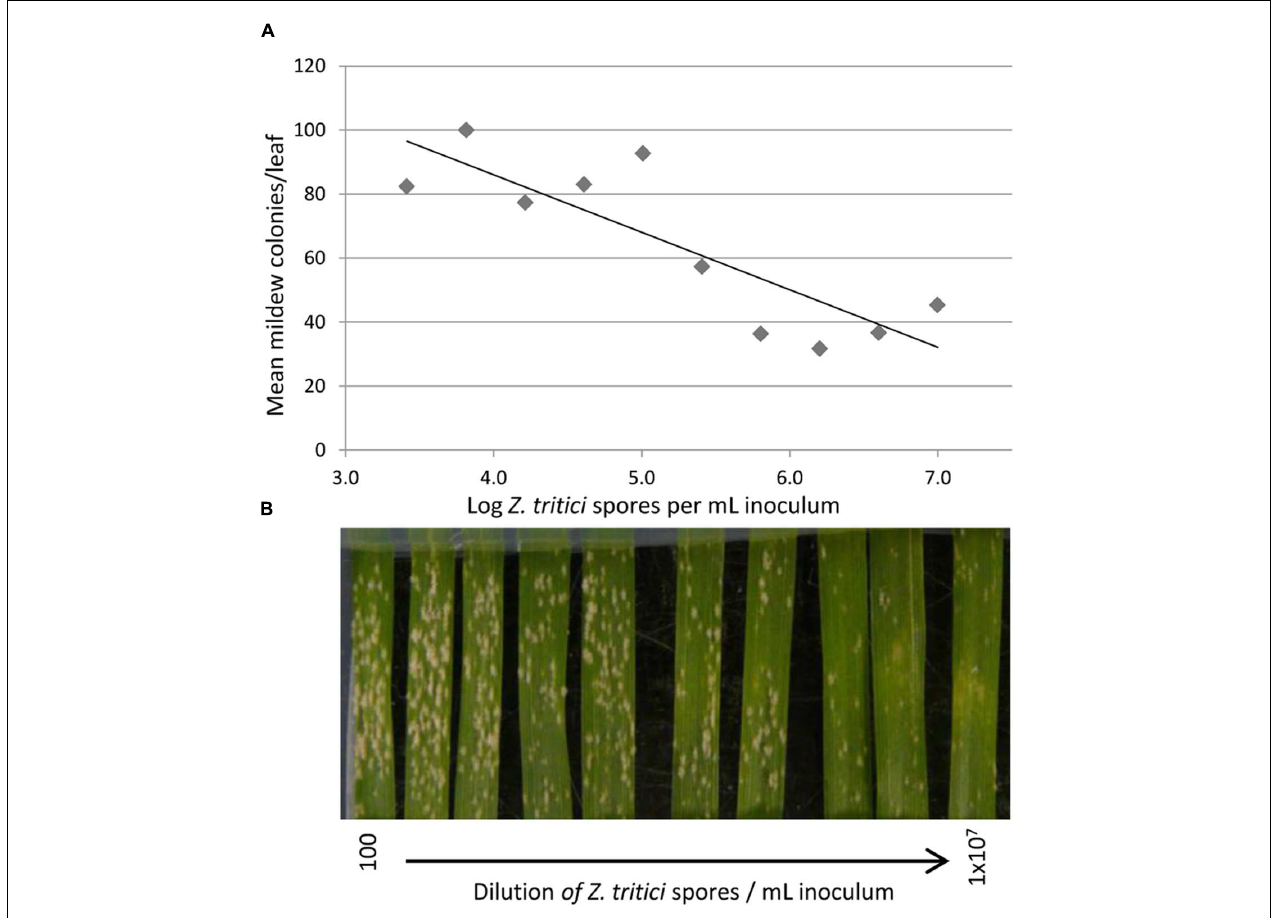
FIGURE 3 | The effect of different concentrations of virulent Z. tritici inoculum on the number of visible colonies of virulent B. graminis f.sp. tritici. Leaves of Longbow were inoculated with decreasing concentrations of Z. tritici spores, from 1 × 10 7 /mL down to 100/mL. (A) A reduction of 18 mildew colonies per leaf was seen for every 10-fold increase in Z. tritici spores: the regression equation of the number of Bgt colonies (B) on the log 10 -concentration of Z. tritici (Z) was B = 158-18Z, R 2 = 0.71. ( P = 0.002 for linear regression). (B) Effect of increasing Z. tritici concentration on mildew colony formation. Photographed 14 days after inoculation with Z. tritici ; 10 days after inoculation with